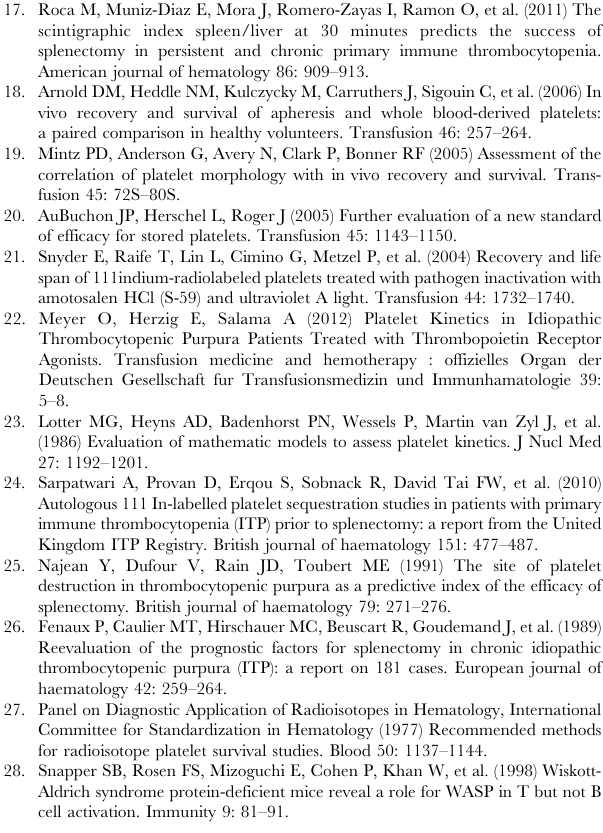
Figure S7 Optimal parameter search for WT to WASP(-) data. A) SS values were determined at the RD value shown. Ranges evaluated for SD were 0.1–0.575 (resolution 0.025; for LS, 105– 124 hr left to right (resolution 1 hr). B) LM1 was evaluated in 20 consecutive RD-defined planes (range 1.1–2.1%/hr, resolution 0.05%/hr) over the LS and SD ranges described in A. All Local minima at RD values of 1.6% or less occur at an LS of 105 hr. C) Diamonds: SS values for the LML shown in (B), normalized to the global minimum. Squares: RD as % of turnover rate for the same LM points. Figure S8 Optimal parameter search WASP(-) to WT data. A) SS values were determined in the RD plane shown. Ranges evaluated for SD were 0.001–0.92 (resolution 0.03); for LS, 1– second 3D plot shows the LML rotated 90 degrees on the vertical